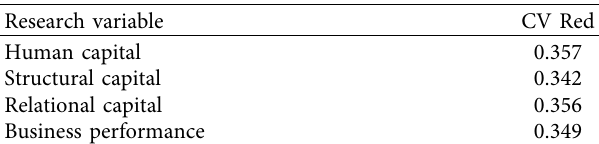
Table 6: Structural model test.